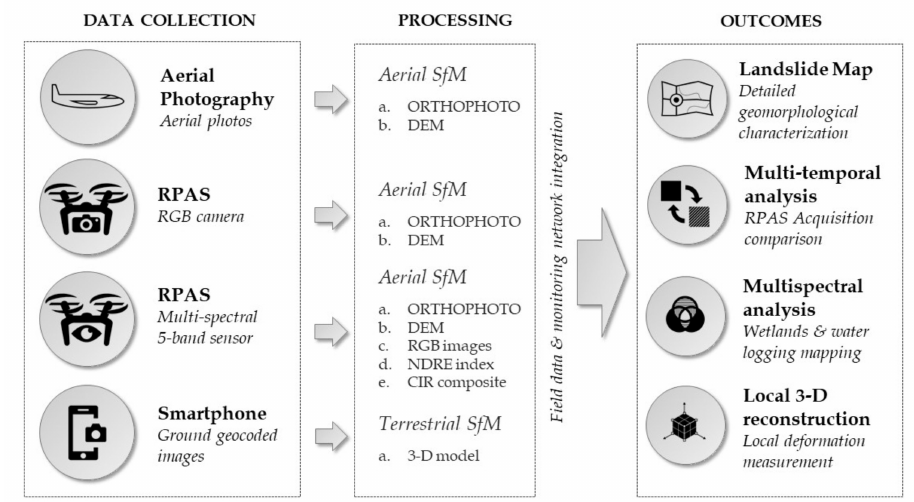
Figure 3. Flow chart of the Structure from Motion (SfM) multisource application methodology for landslide